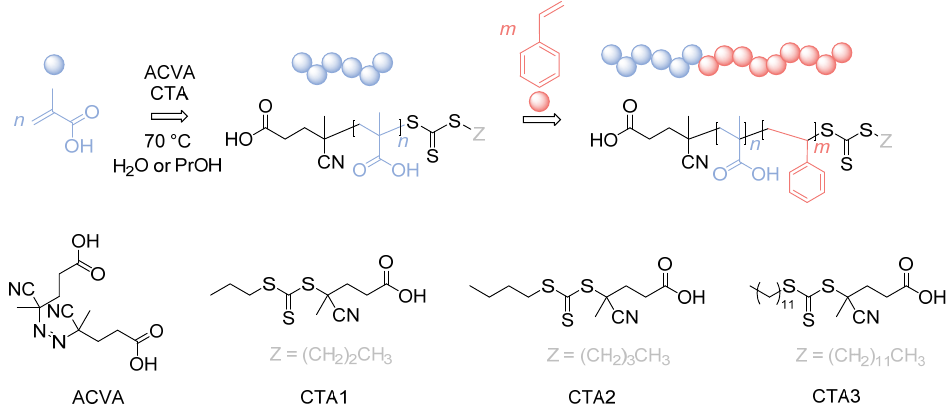
Figure 1. Reaction overview of the RAFT polymerization of PMAA- b -PS diblock copolymers using three different CTAs. CTA1: 4-Cyano-4-thioylthiopropylsulfanyl pentanoic acid (CPP), CTA2: 4-Cyano-4-thioylthiobutylsulfanyl pentanoic acid (CBP), CTA3: 4-Cyano-4-thioylthiododecylsulfanyl pentanoic acid (CDTPA).